Question: State the chart type depicted above.
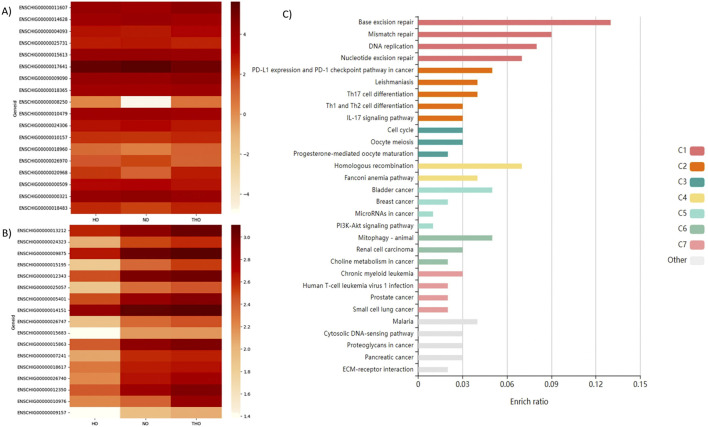
Answer: heatmap